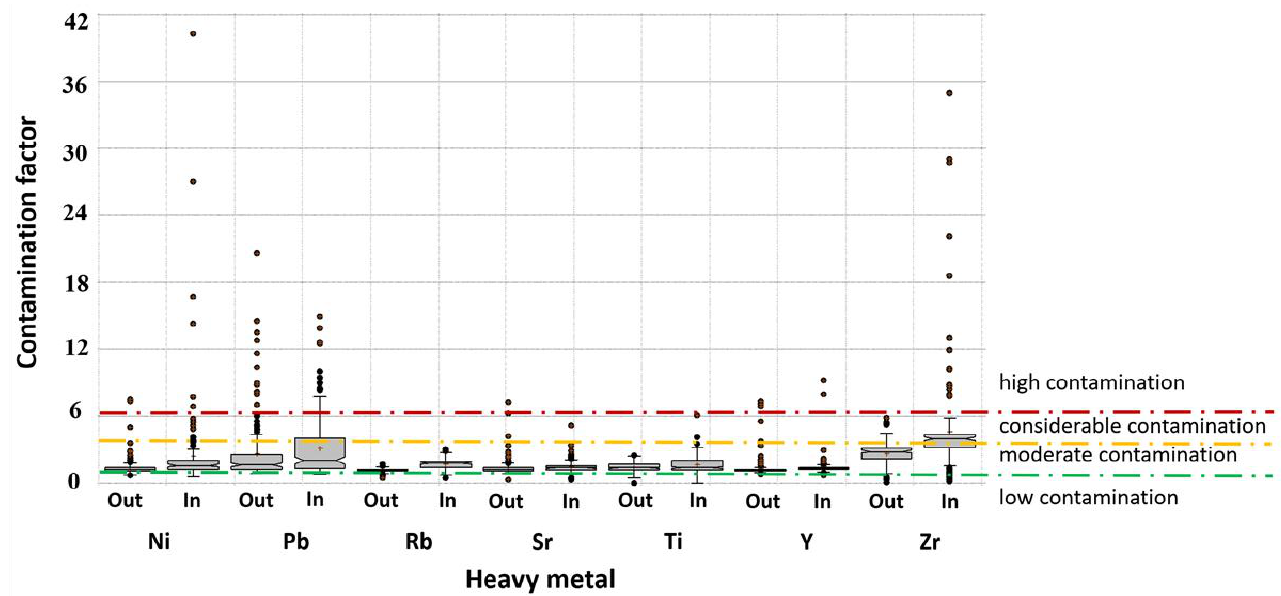
Figure 5. Boxplots for heavy metal contamination factors using the first decile as the background value.